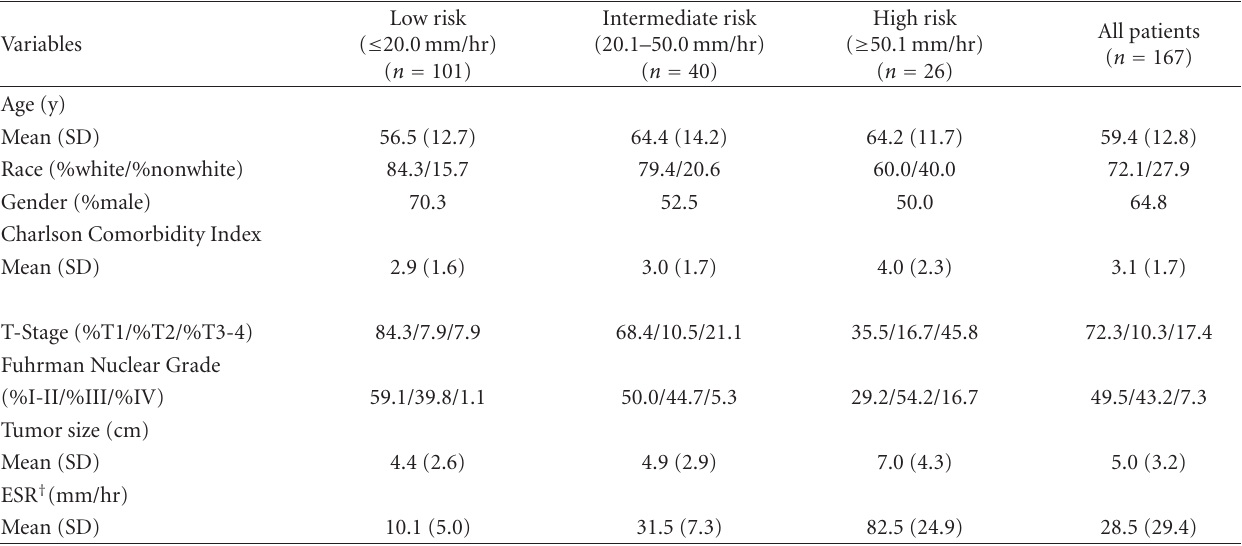
Table 1: Patient characteristics.